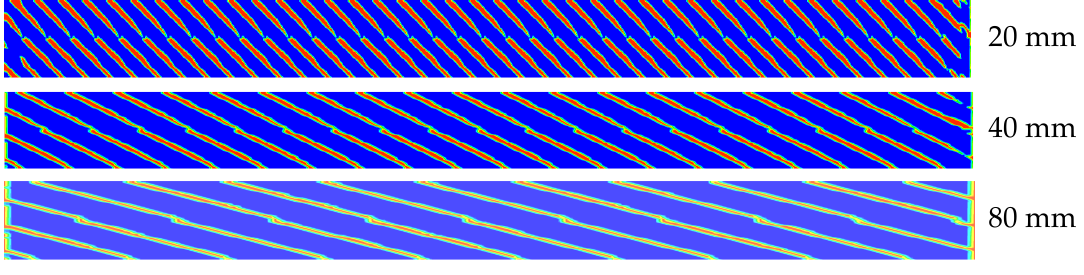
Figure 11. Degree of fill distribution of different screw pitches.